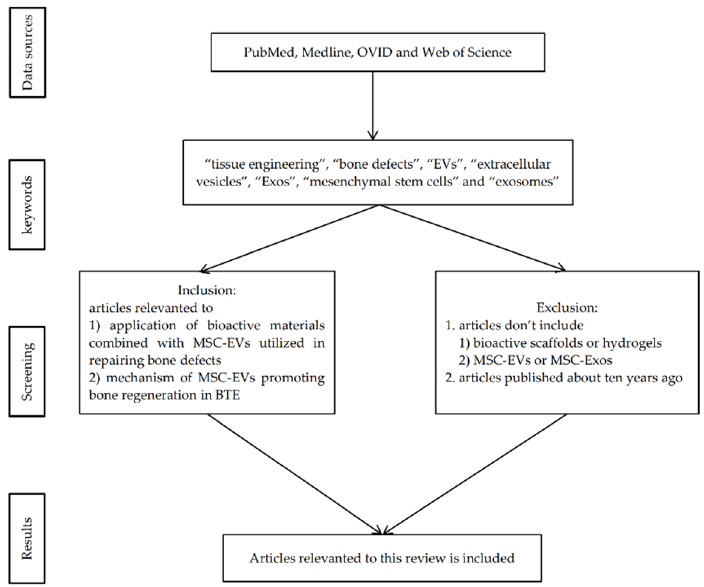
Figure 1. The flowchart for literature screening.